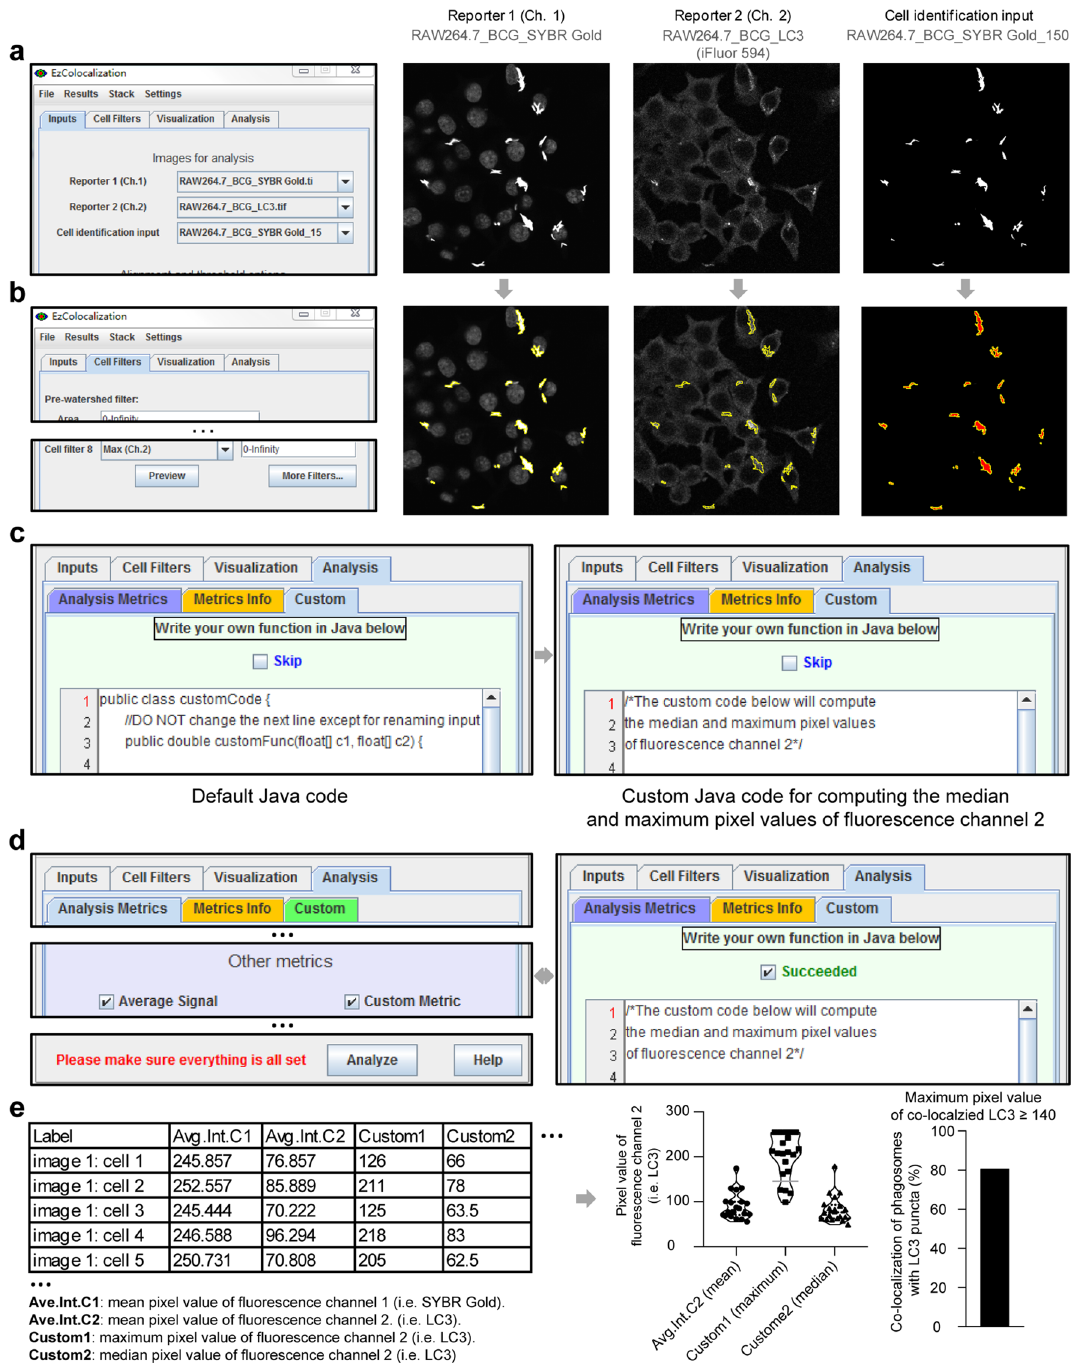
Figure 2. Protocol to export mean, maximum, median pixel values (PVs) of a reporter. ( a ) Inputting the monochromatic images. ( b ) Locating the region of intracellular BCG/phagosomes in “Cell identification input” (yellow margins filled with red), and the corresponding overlapping regions in reporter 1 and reporter 2. ( c ) Inputting custom Java code for exporting maximum and median PVs of reporter 2 in fluorescence channel 2. ( d , e ) Exporting and plotting the mean, maximum, median PVs of a reporter, and empirically calculating the percentage of engulfed BCG/phagosomes co-localized with reporter 2 (i.e. LC3